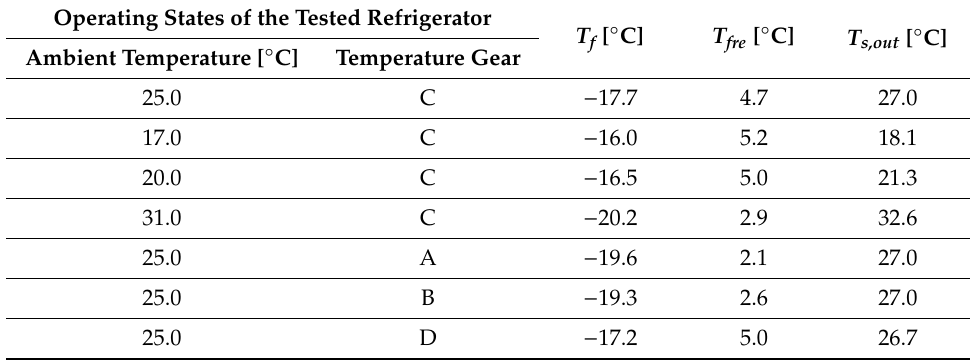
Table 1. Boundary conditions under di ff erent temperature gears and ambient temperatures